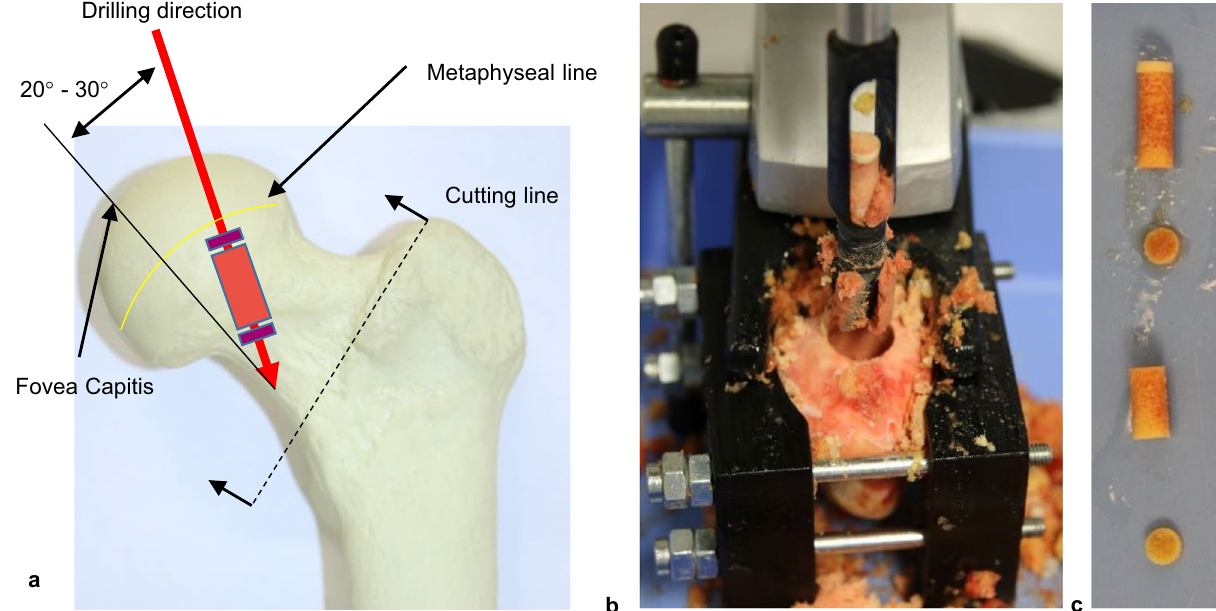
Figure 1. Specimen preparation: ( a ) shows the location of the samples within the available bone region. The drill penetrates into the diaphysis with an angle of 20°–30° in lateral direction, starting from the fovea capitis. In ( b ) a femoral head fixed in the clamping jaws can be seen immediately after drilling. The fovea capitis is visible in ( b ) as a yellow and dark red spot below the drill hole. The already cut drill core can be seen in ( c ). The parts are arranged from proximal (top) to distal